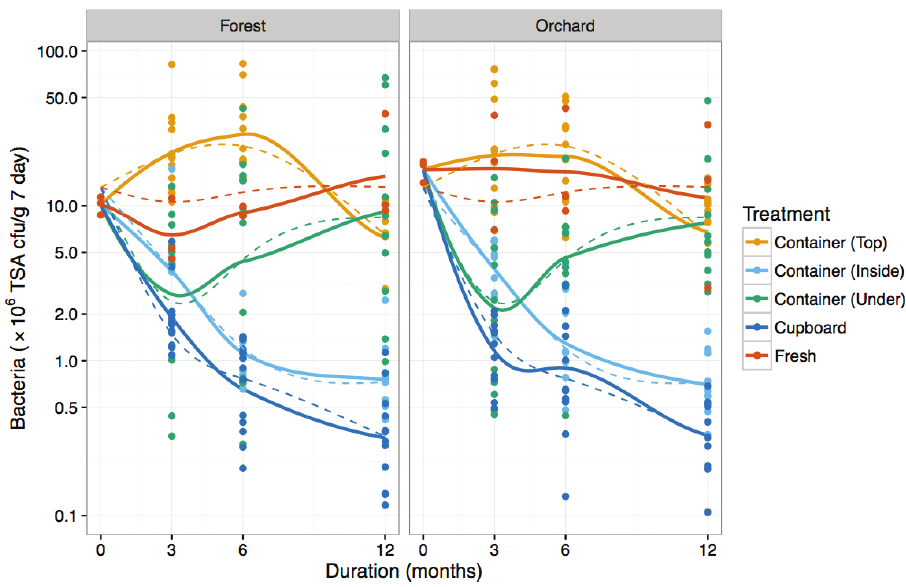
Figure 1. Scatterplot of mean bacterium counts (cfu/g) at 0, 3, 6 and 12 months measured in soil recovered from on, in and under four sea containers and inside four cupboards. Solid lines show the smoothed means and dashed lines predictions from the preferred model.